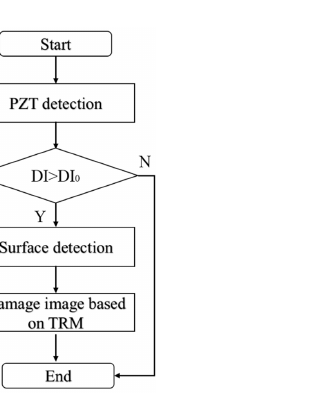
Figure 5. The time reversed method detecting procedure of reinforced concrete component.